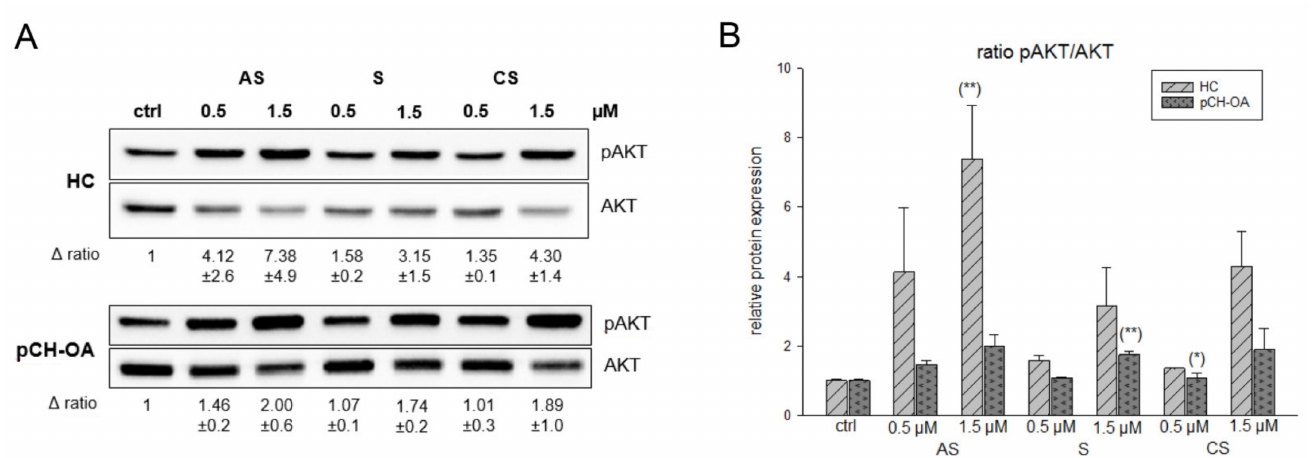
Figure 3. Shikonin derivatives induced an activation of AKT phosphorylation. ( A ) The AKT protein phosphorylation was evaluated by immunoblotting under untreated control conditions (ctrl) and in the presence of 0.5 µ M and 1.5 µ M acetylshikonin (AS), shikonin (S), and cyclopropylshikonin (CS) for 1 h in HC and IL-1 β -stimulated pCH-OA cells. AKT was used as loading control. ∆ ratio represents the fold change of pAKT/AKT normalized to controls (mean ± SD, n = 3). ( B ) shows the densiometric evaluation of all experiments in HC (light grey striped) and pCH-OA (dark grey dotted) cells. Statistical significances are defined as follows: * p < 0.05; ** p <